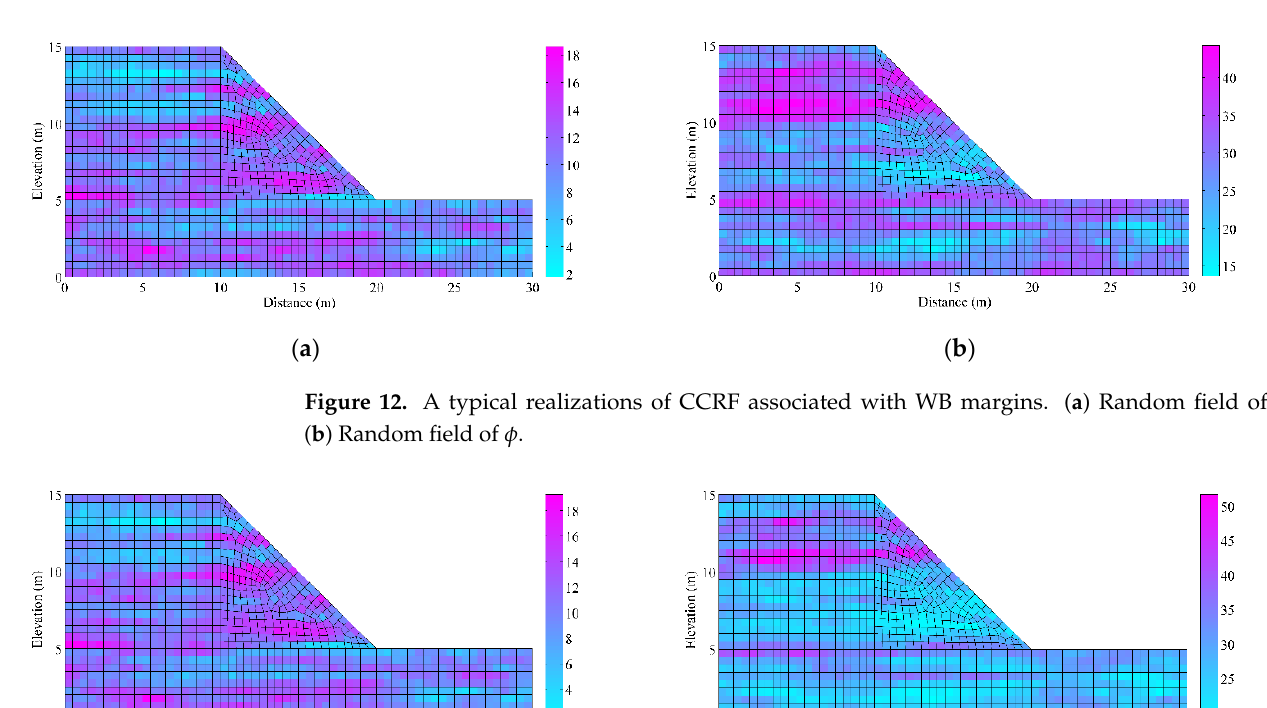
Figure 11. A typical realization of CCRF associated with TG margins. ( a ) Random field of c . ( b ) Random field of ϕ.